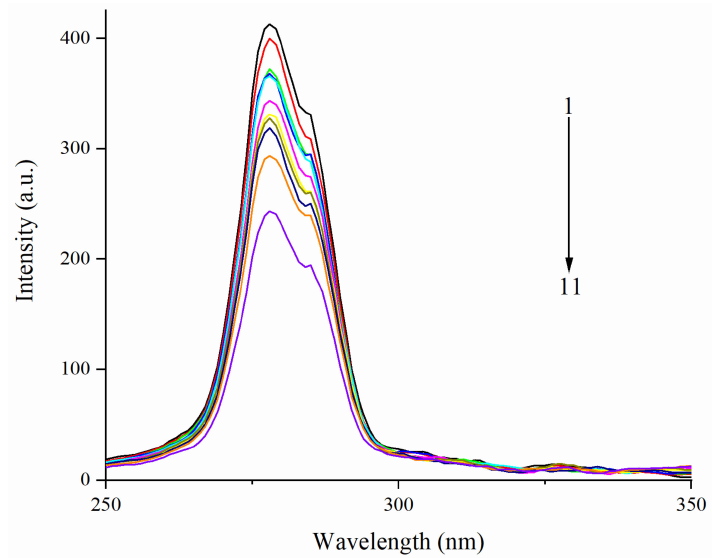
Figure 4. Effect of EA on synchronous spectra of zein. Note: effect of EA on synchronous spectra of zein with ∆ λ = 15 nm; EA: ellagic acid; the concentration of zein is 0.05 mg/mL; curve 1: black curve (0 mg/mL EA); 2: red curve (0.1 mg/mL EA); 3: green curve (0.2 mg/mL EA); 4: blue curve (0.3 mg/mL EA); 5: cyan curve (0.4 mg/mL EA); 6: magenta curve (0.5 mg/mL EA); 7: yellow curve (0.6 mg/mL EA); 8: dark yellow curve (0.7 mg/mL EA); 9: navy curve (0.8 mg/mL EA); 10: orange curve (0.9 mg/mL EA); 11: violet curve (1.0 mg/mL EA).